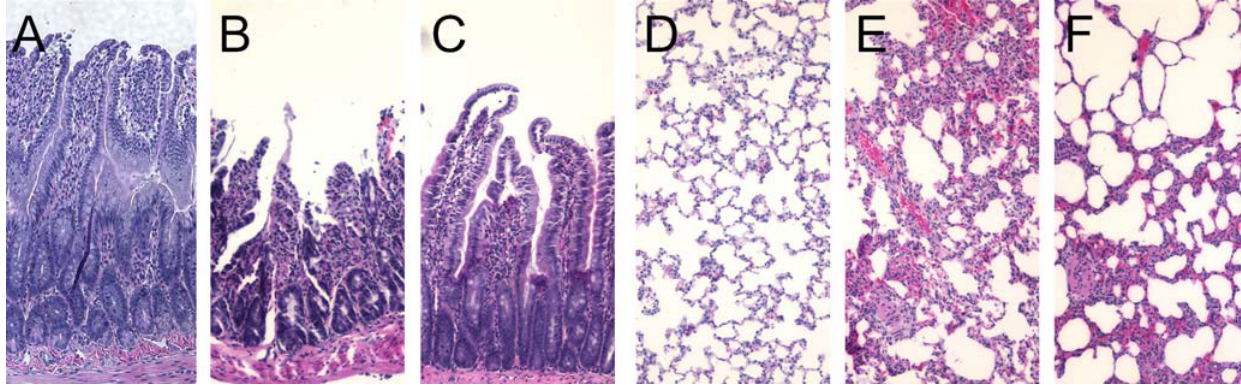
Figure 6. Alterations in morphologic photomicrography of the small intestine and lungs. A , a photomicrograph of a small intestinal section from a sham-operated rat; B , a photomicrograph of a small intestinal section from an I/R rat at 2 h after gut ischemia-reperfusion treated with vehicle; C , a photomicrograph of a small intestinal section from an I/R rat at 2 h after gut ischemia-reperfusion treated with ghrelin; D , a photomicrography of a pulmonary section from a sham-operated rat. E , a photomicrography of lung section from an I/R rat at 2 h after gut ischemia- reperfusion treated with vehicle; F , a photomicrography of lung section from an I/R rat at 2 h after gut ischemia-reperfusion treated with ghrelin. Original magnification, 6 200.